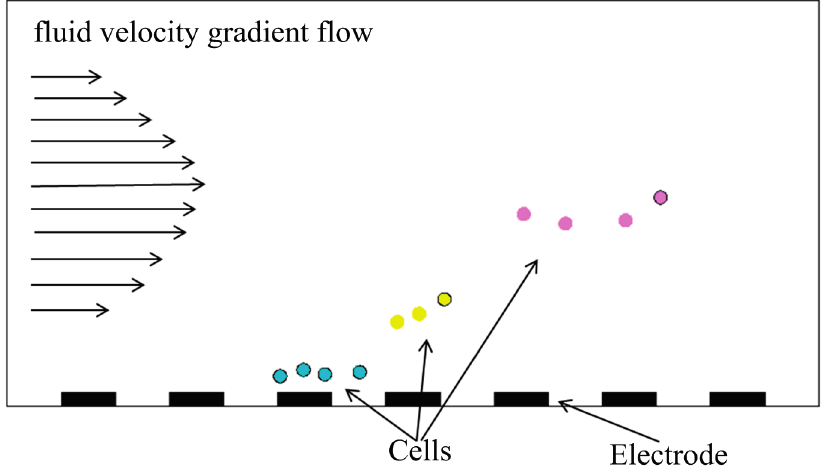
Figure 7. Schematic diagram of DEP field-flow